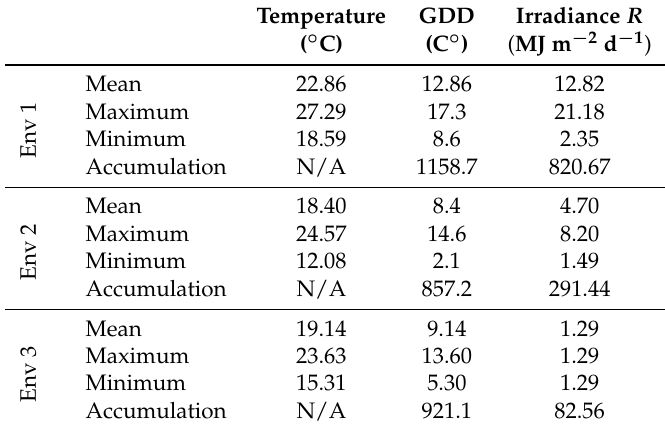
Table 1. Descriptive statistics of the control parameters in three different climatic environments. Env,